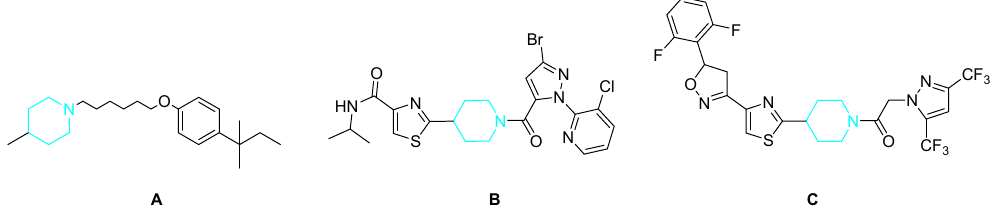
Figure 2. The structure of the piperidine derivatives. ( A ) Histamine H 3 R ligands; ( B ) antifungal activity; ( C ) fungicide oxathiapiprolin.